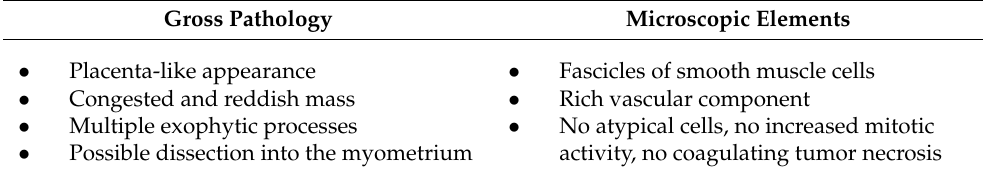
Table 3. The pathological features of cotyledonoid leiomyoma.